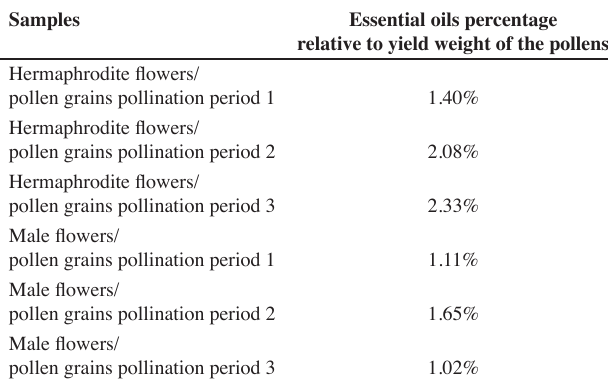
Tab. 5: Essential oils content relative to pollen grain